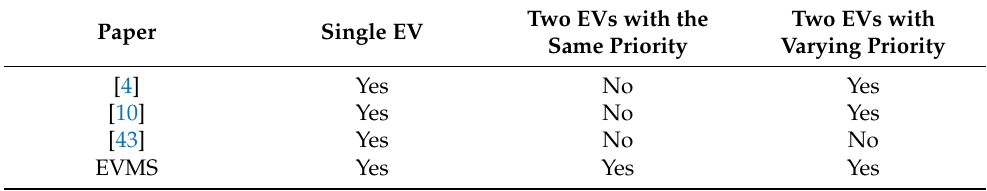
Table 6. Comparison with existing